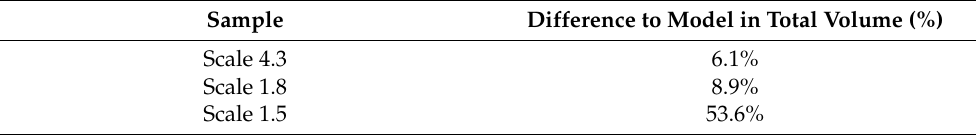
Table 7. Quantification of the volumetric differences between the input model and printed parts.